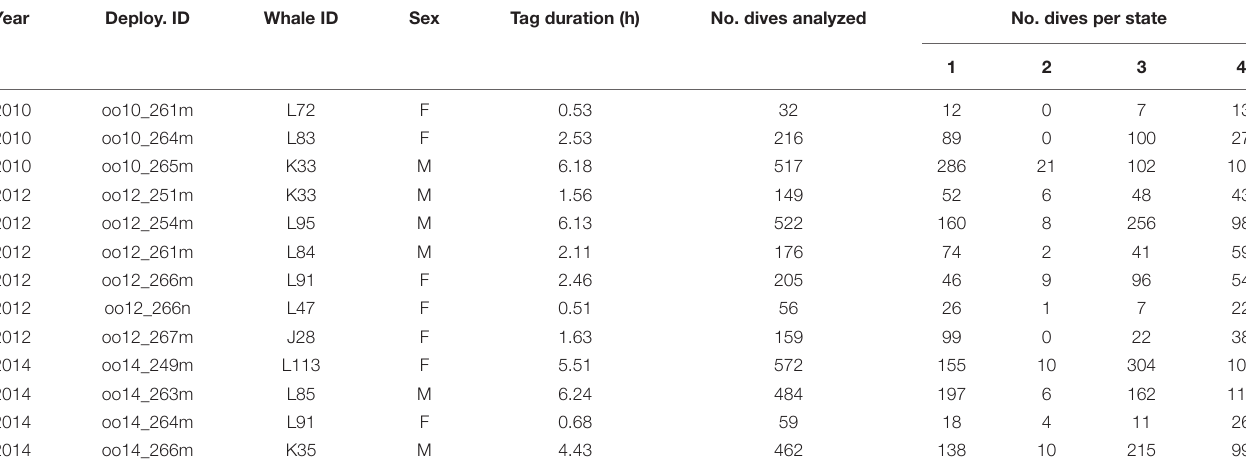
TABLE 1 | Summary of analyzed Dtag